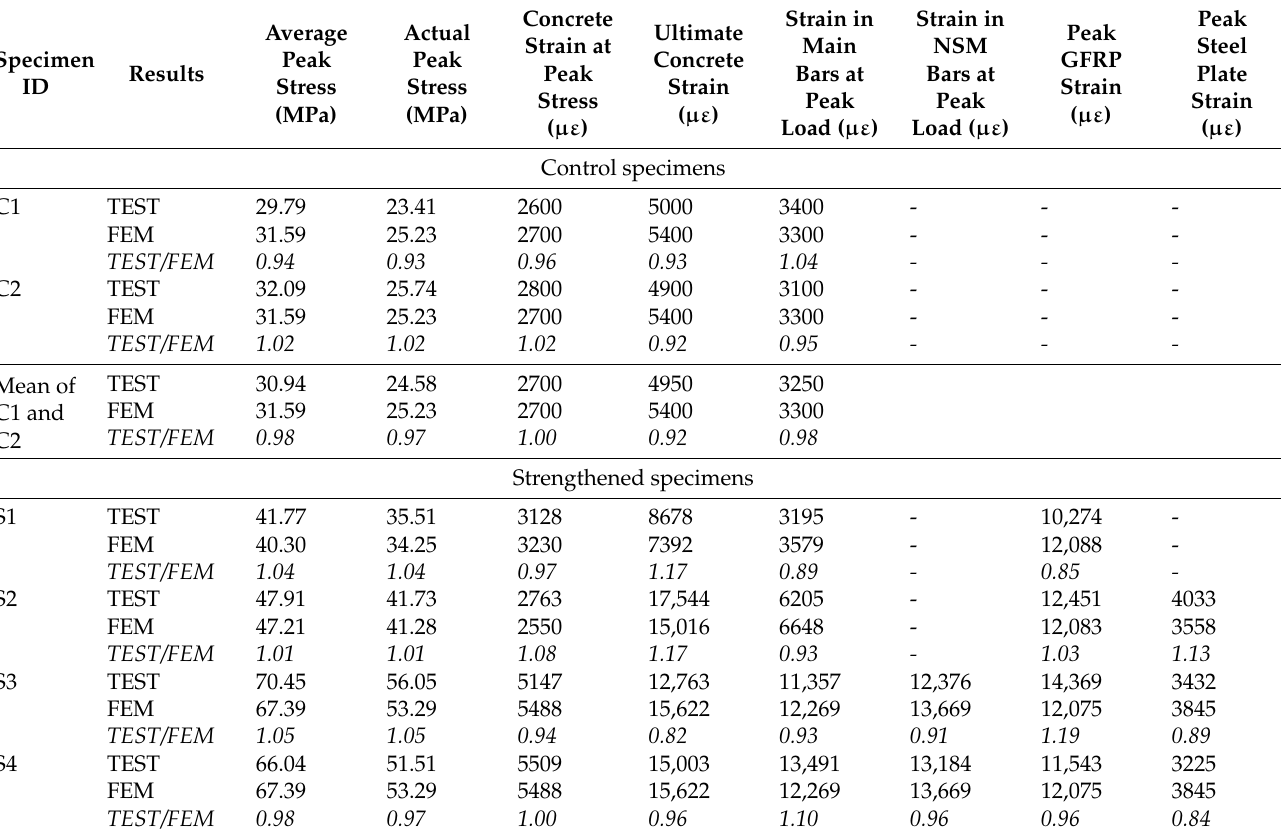
Table 4. Key results of stress versus strain response for tested specimens.